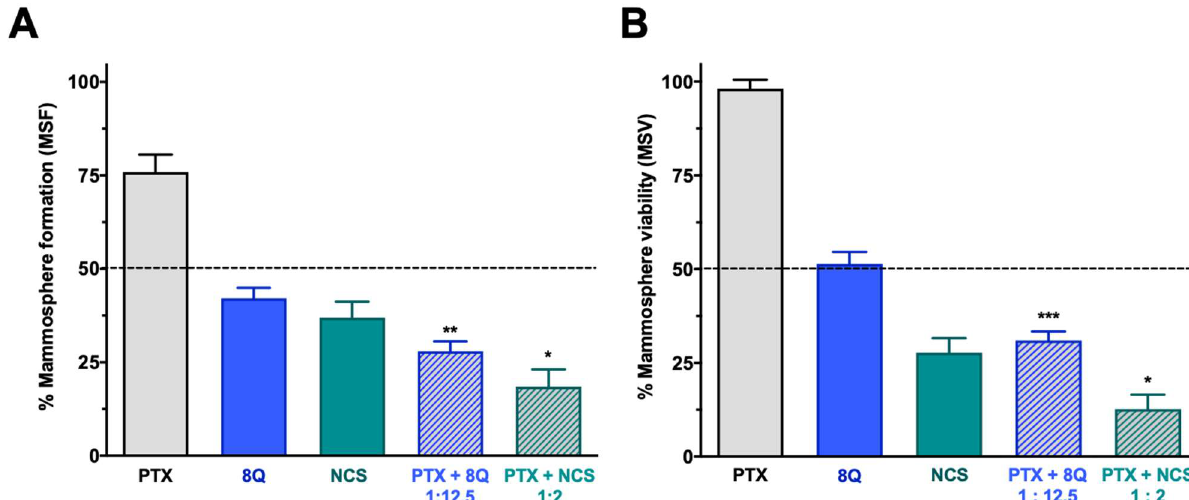
Figure 6. Effect of the combination of 8Q or NCS with PTX in MDA-MB-231 mammospheres. ( A ) Mammosphere-forming (MSF) efficiency of PTX, 8Q, NCS and their combination (2 µM, 25 µM and 4 µM, respectively). ( B ) Mammosphere viability (MSV) of PTX, 8Q, NCS and their combination (4 µM, 50 µM and 8 µM, respectively). Results are represented as the mean ± SEM of three independent experiments and referred to as the non-treated control condition. Statistical t-test analysis was performed comparing combination therapy with single anti-CSC treatments at the corresponding equivalent drug dose (* p < 0.05, ** p < 0.01, *** p < 0.001).